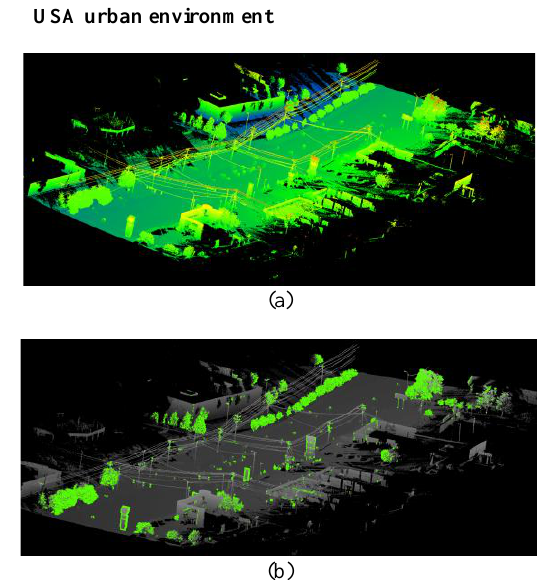
Figure 4. USA urban environment; (a) Collected LiDAR point clouds and (b) Outputs acquired by the proposed algorithm.